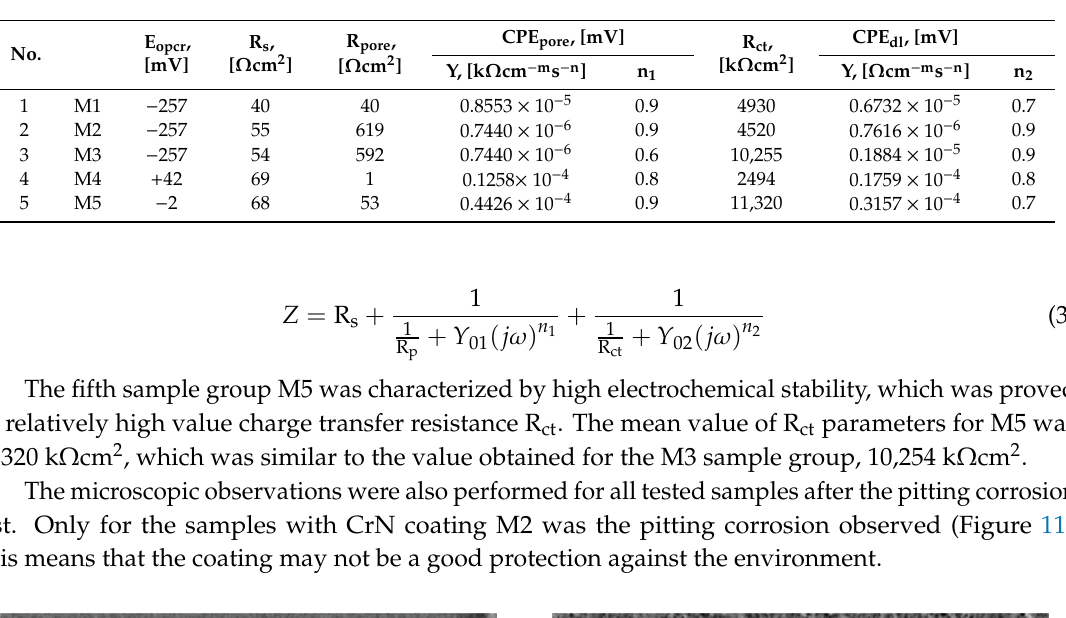
Figure 10. Electric substitute scheme. Table 9. Results of EIS test.